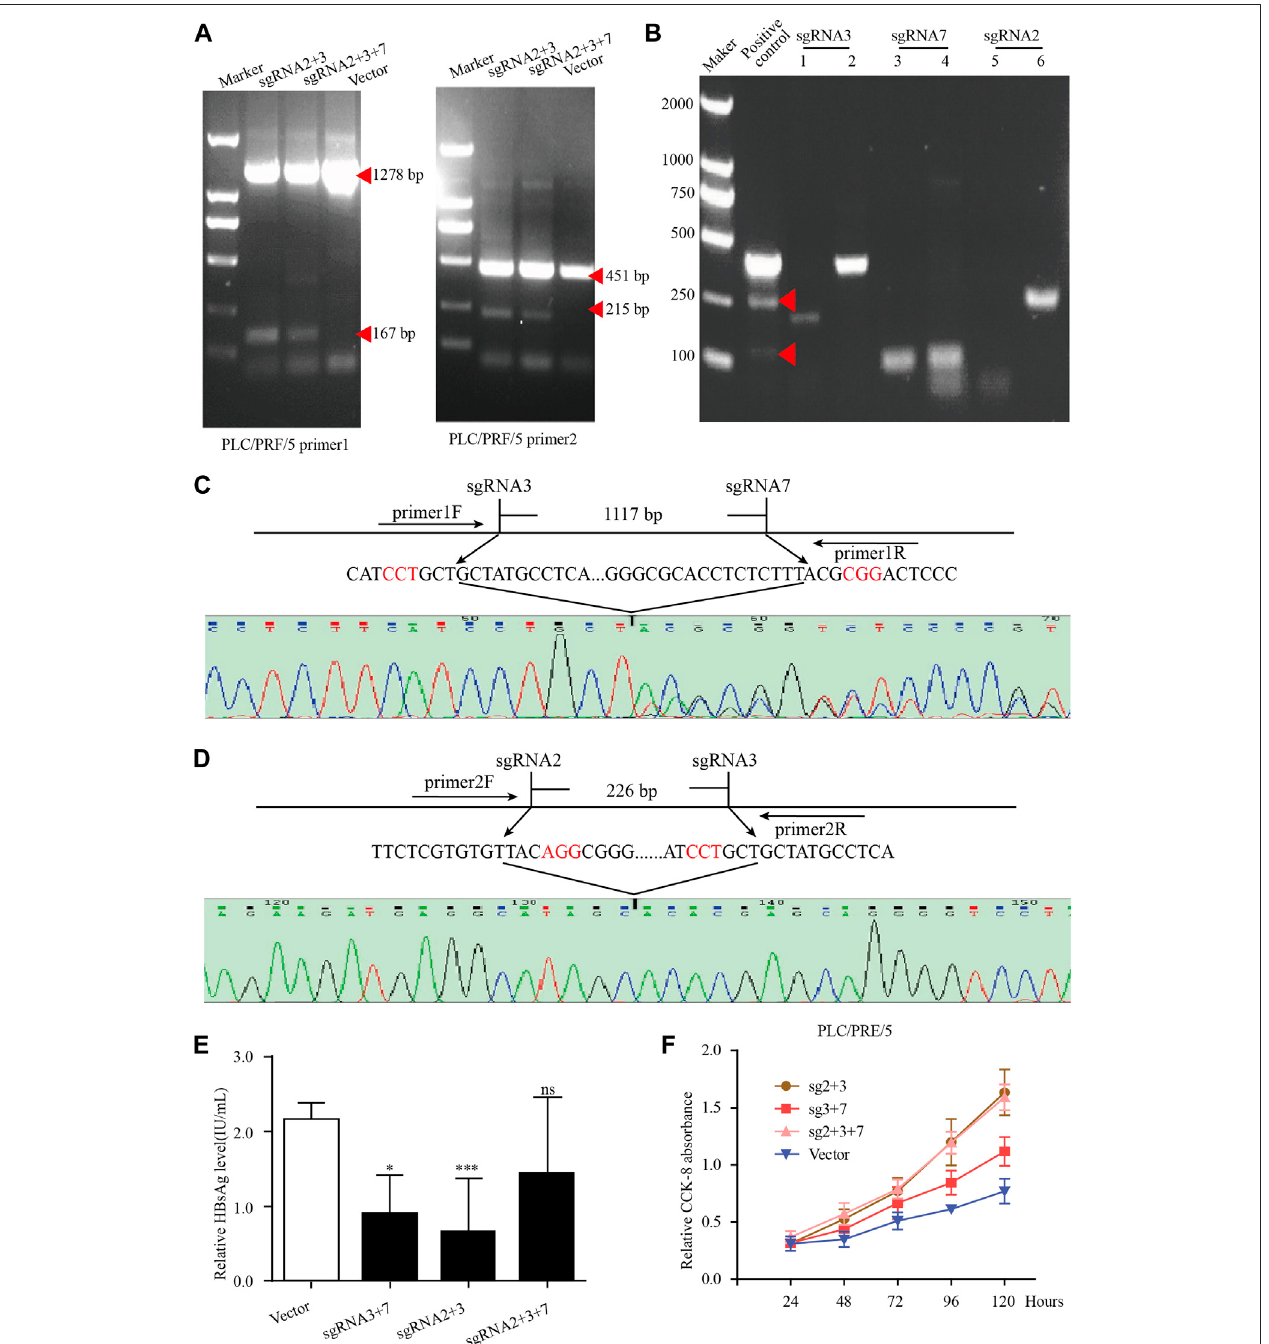
FIGURE 6 | The knockout of integrated HBV S gene by CRISPR/Cas9 system in PLC/PRF/5 cells. (A) The plasmid pBB4.5-HBV1.2 (0.5 μ g) was co-transfected with gRNA2+3, gRNA3+7 and gRNA2+3+7 expression vectors (each 0.75 μ g) to PLC/PRF/5 cells. Cellular DNA was extracted at 72 h post transfection, and PCR ampli fi cations were performed using the primers beyond the cleavage sites of each dual gRNAs. (B) The off-target effect of sgRNA was detected by T7 endonuclease I assay. Each sgRNA detected the two most likely off-target sites. (C – D) Sequencing analysis of the smaller fragment formed by sgRNA3+7 and sgRNA2+3. (E) . HBsAg level in culture supernatant was measured by using an enzyme-linked immune sorbent assay. Data are shown as mean ± SE of 3 independent samples. Statistical method: t test (two-side), * means p < 0.05, ** means p < 0.01,*** means p < 0.001. (F) The cell proliferation of PLC/PRF/5 cells after transfecting different sgRNAplasmids.CellstransfectedwithemptyPX458plasmidwereusedascontrolgroup.Dataareshownasmean ± SEof3independentsamples.Statisticalmethod: t test (two-side).